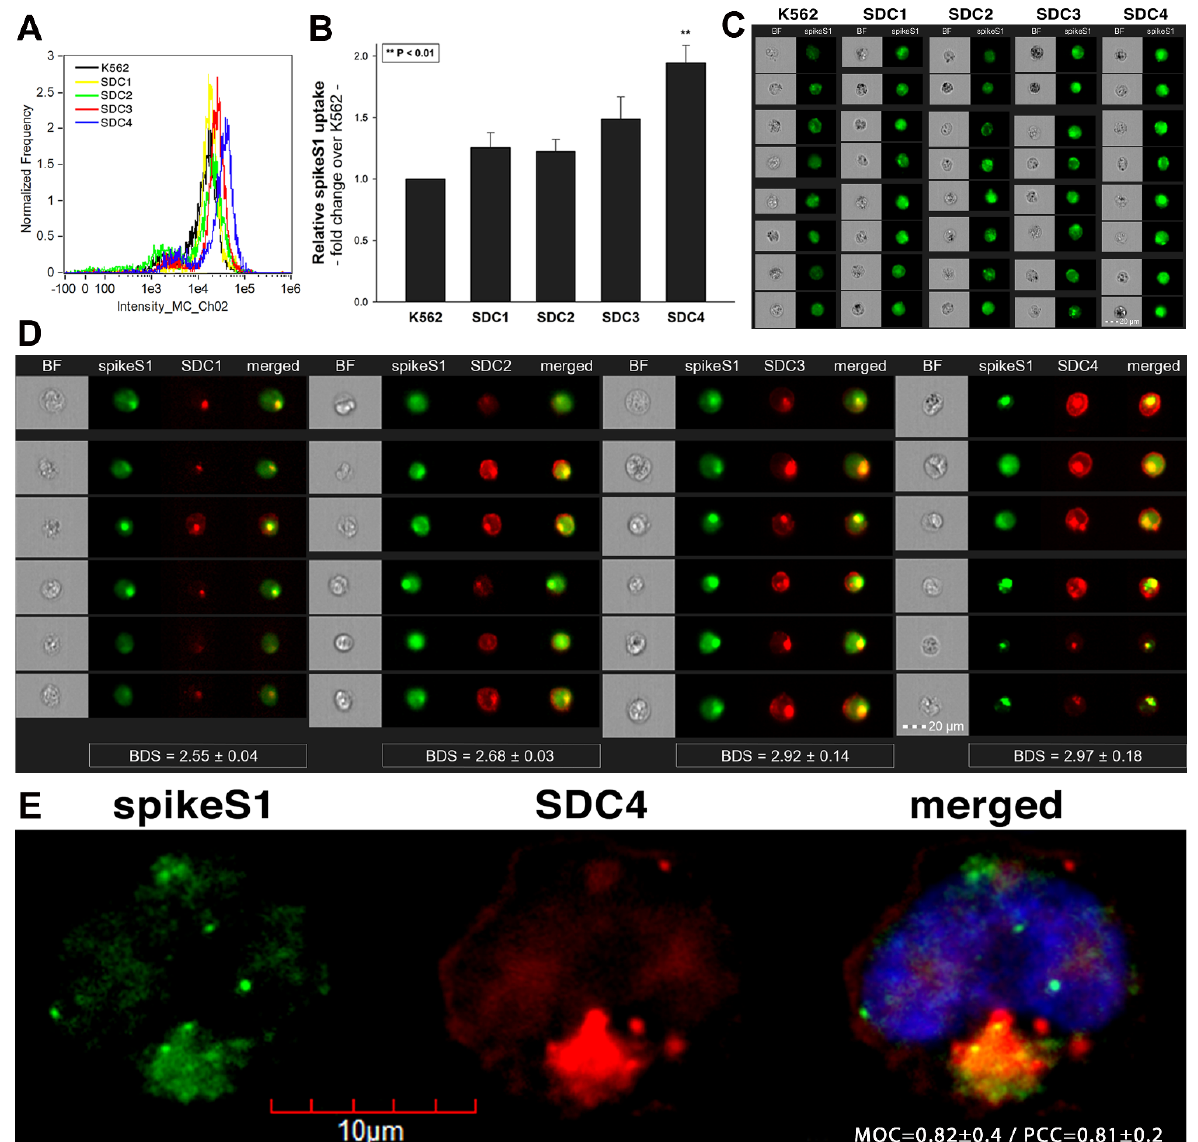
Figure 6. Cellular uptake of spikeS1 into SDC transfectants. WT K562 cells and SDC transfectants were incubated with spikeS1 for 18 h at 37 °C. After incubation, the cells were washed, trypsinized, fixed, permeabilized and treated with FITC-labeled antibodies specific for the N-terminal His-tag of the recombinant spikeS1. Cellular uptake of spikeS1 was then analyzed with imaging flow cytometry and confocal microscopy. ( A ) A representative flow cytometry histogram showing the intracellular fluorescence of spikeS1-treated WT K562 cells and SDC transfectants. ( B ) Detected fluorescence intensities were normalized to spikeS1-treated WT K562 cells as standards. The bars represent the mean ± SEM of three independent experiments. Statistical significance vs. standards was assessed with ANOVA. ** p < 0.01. ( C ) BF and fluorescent cellular images of spikeS1-treated WT K562 cells and SDC transfectants. Scale bar = 20 μm. ( D ) Imaging flow cytometry visualization of colocalization between SDCs and spikeS1. Representative images of four independent experiments are shown. Scale bar = 20 μm. The indicated BDS of spikeS1 and SDCs represent the mean ± SEM of four independent experiments. Statistical significance between the groups was assessed with ANOVA. No statistically significant differences were detected. ( E ) Colocalization of spikeS1 and SDC4 detected with confocal microscopy. Representative images of three independent experiments are shown. Scale bar = 10 μm. MOC ± SEM and PCC ± SEM for the overlap and colocalization of SDC4 with spikeS1 (indicated on the image) was calculated by analyzing 12 images with an average of 12 cells in each image (from 3 separate samples).